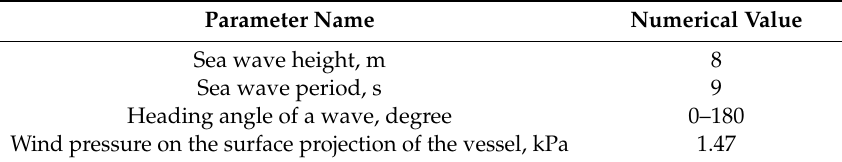
Table 2. Parameters of sea waves used in mathematical